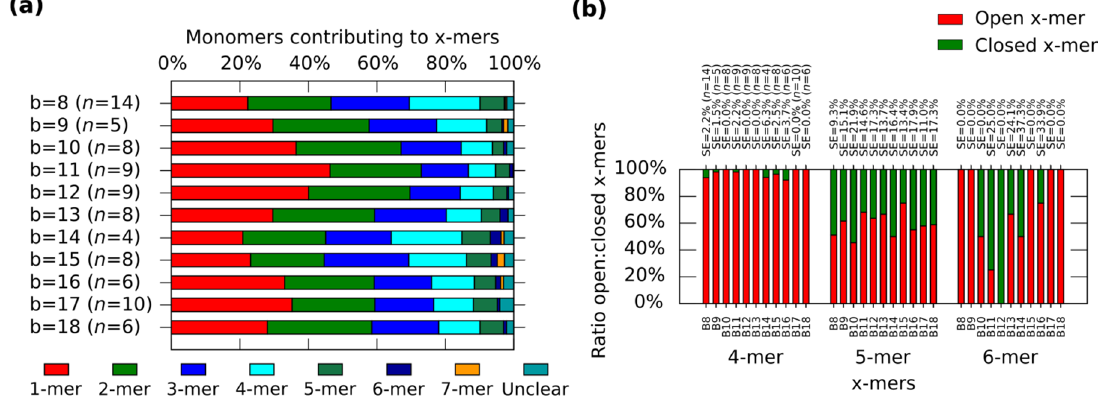
Figure 4. Distributions of the clusters after reconfiguration for M (0, b ) ( b = 8 − 18). ( a ) Distribution of monomers contributing to the formation of x -mers including open and closed states. Colours indicate each type of cluster. Yellow indicates open 7-mer. Analysed AFM areas are 2240 nm × 1680 nm; ( b ) Ratio open:closed clusters for 4-mers, 5-mers and 6-mers. Error bars in ( a ) and SE in ( b ) indicate the standard error. n indicates the